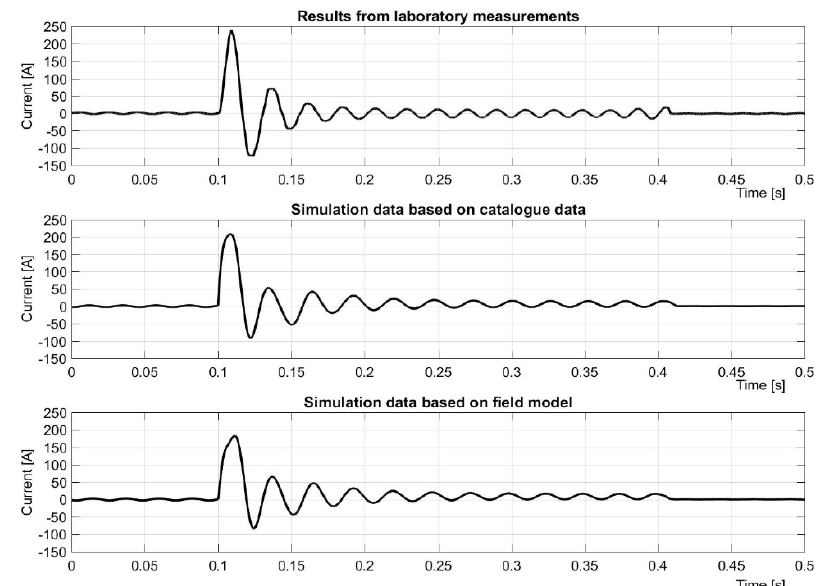
Figure 6. Waveform of the short-circuit current phase for L 1 phase (first phase of generator) of the synchronous generator for a short-circuit case modeled directly on the generator clamps.